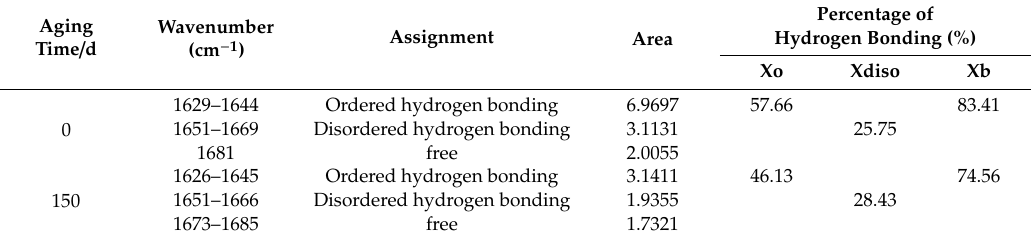
Table 1. Degree of hydrogen bonding in the polyurea obtained from the deconvolution of the carbonyl stretching region.